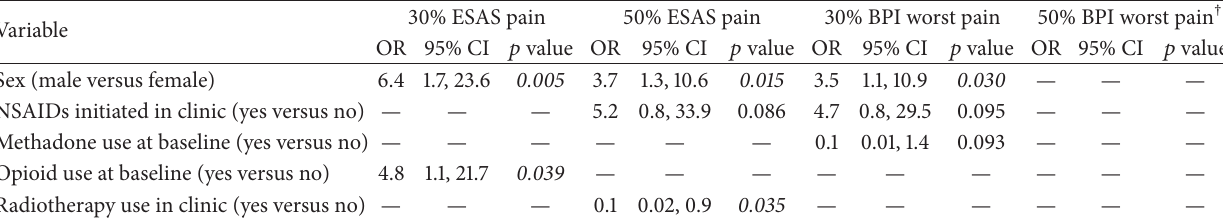
Table 8: Predictors of positive analgesic